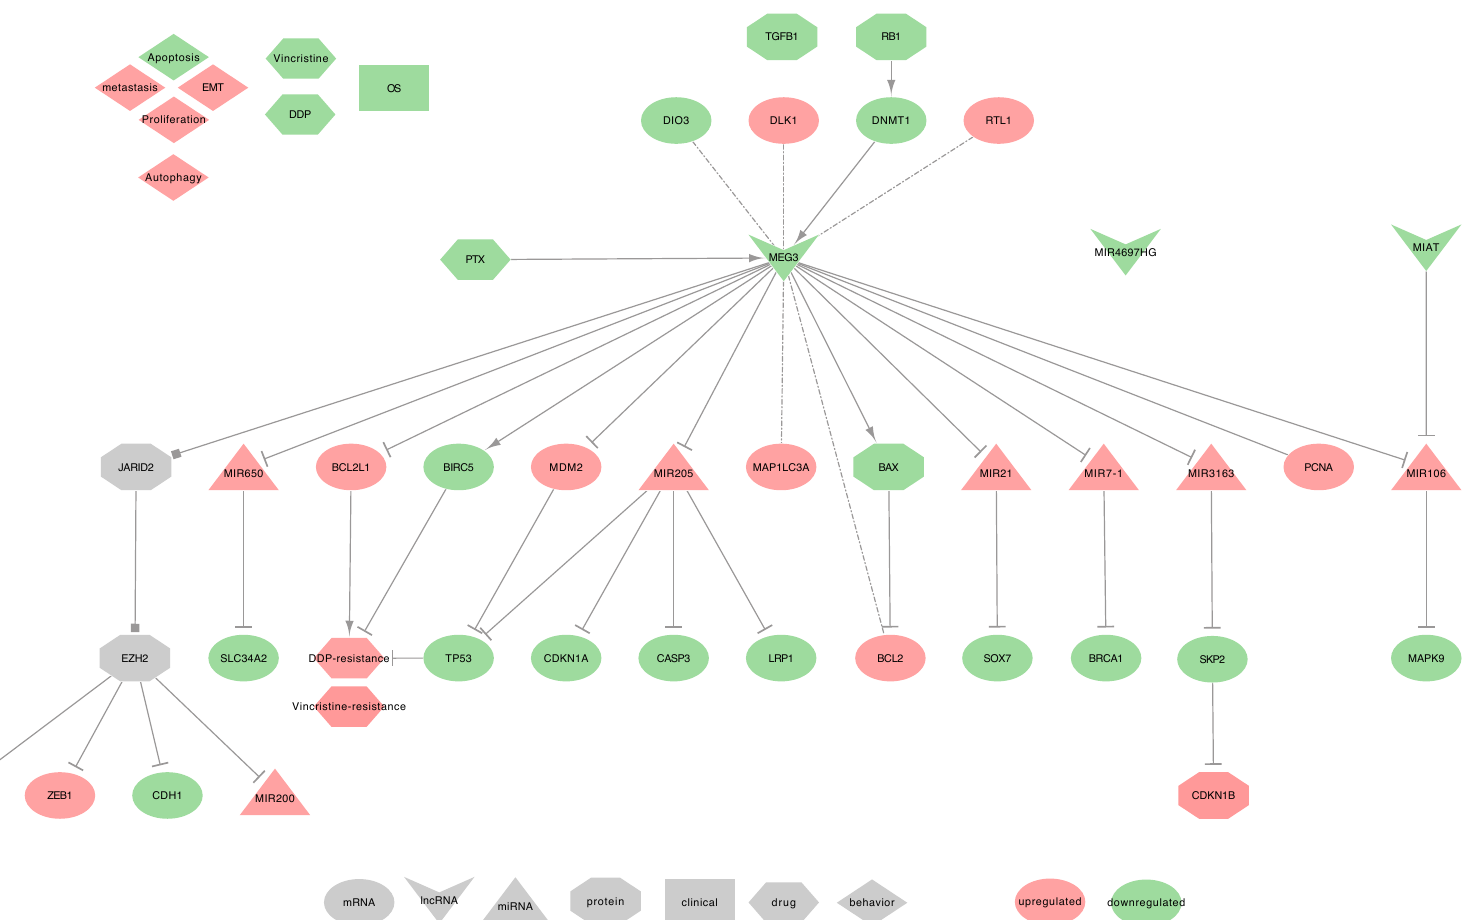
Figure 6. MEG3 in lung cancers: A network of lncRNA-miRNA-Protein interactions. Upregulated molecules are in green. Downregulated molecules are in red. Shape definitions are in grey. Gray arrows target the activated molecules. T-ended lines target the inhibited molecules. Square-ended lines represent a binding between molecules. Dashed-dot lines represent an association with unknown